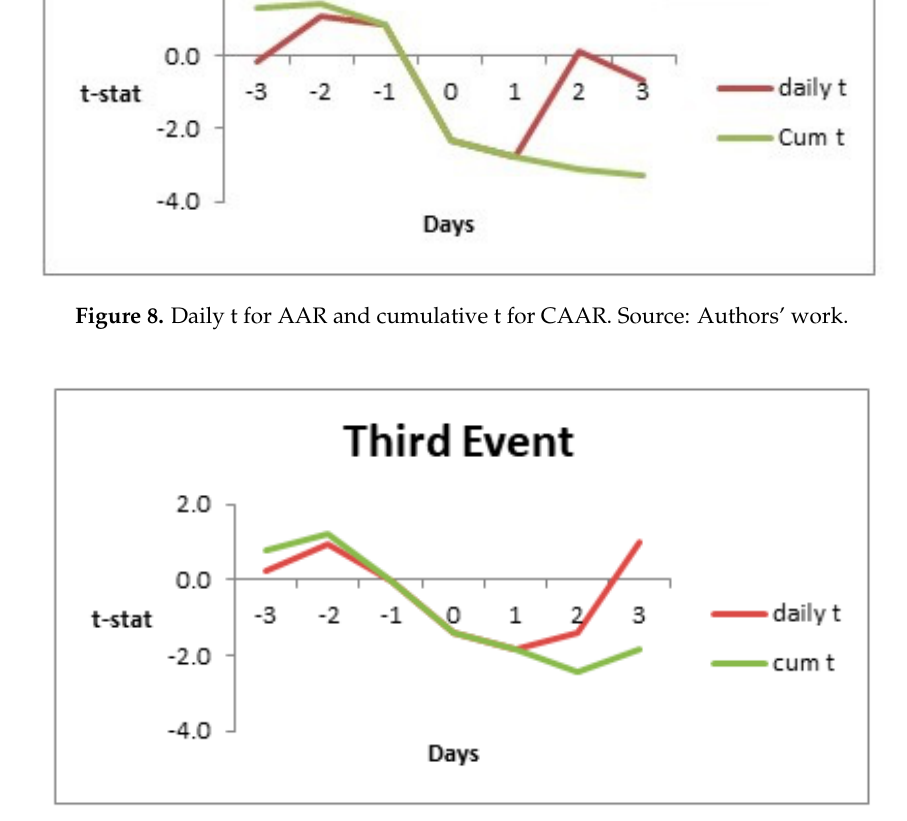
Table 6. Event study results of insurance companies for the first event. Source: Authors’ work.